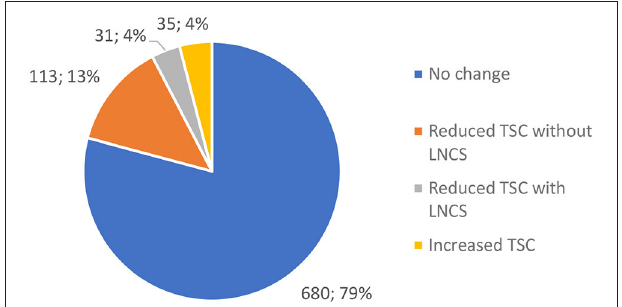
FIGURE 1 | Changes in the total sugar content (TSC) in beverages available in 2020, which were also found in the 2017/2019 dataset ( N = 859; LNCS–low- and/or no-calorie